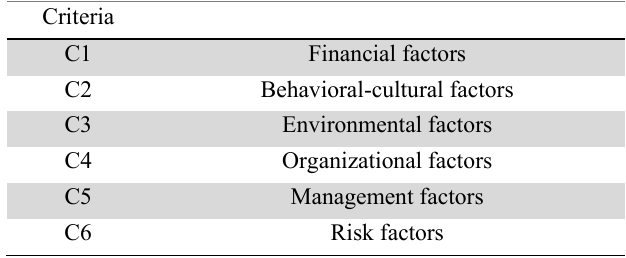
The criteria and